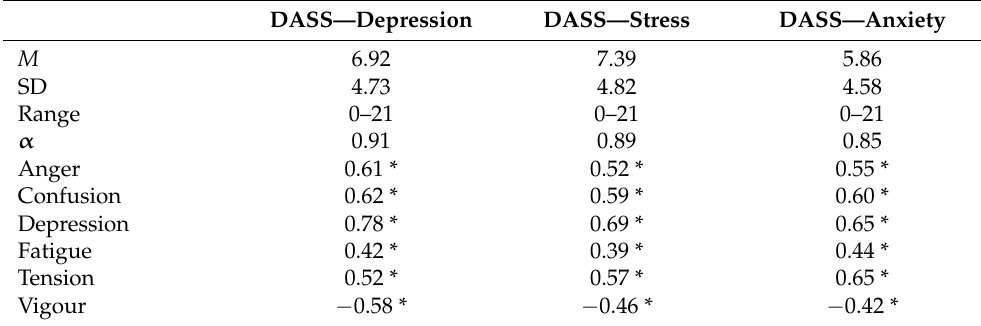
Table 9. Descriptive statistics and reliabilities for DASS-21 subscales and two-tailed correlations with MASMS subscales ( n = 302).